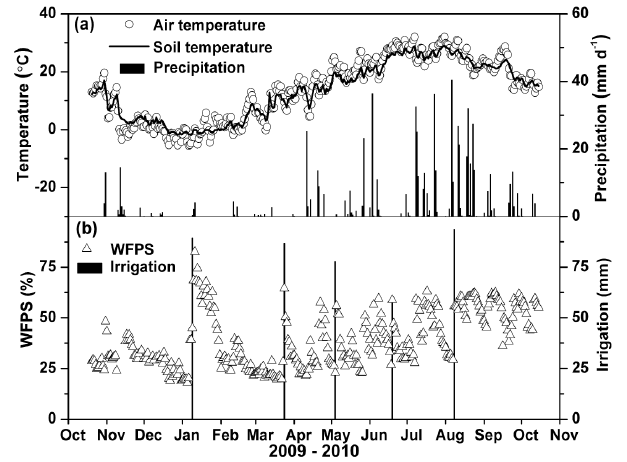
Fig. 2. Temporal courses of (a) daily averaged air and soil tem- peratures, daily precipitation, and (b) soil water-filled pore space (WFPS) and irrigation amount at the experimental field (urea treat- ment).